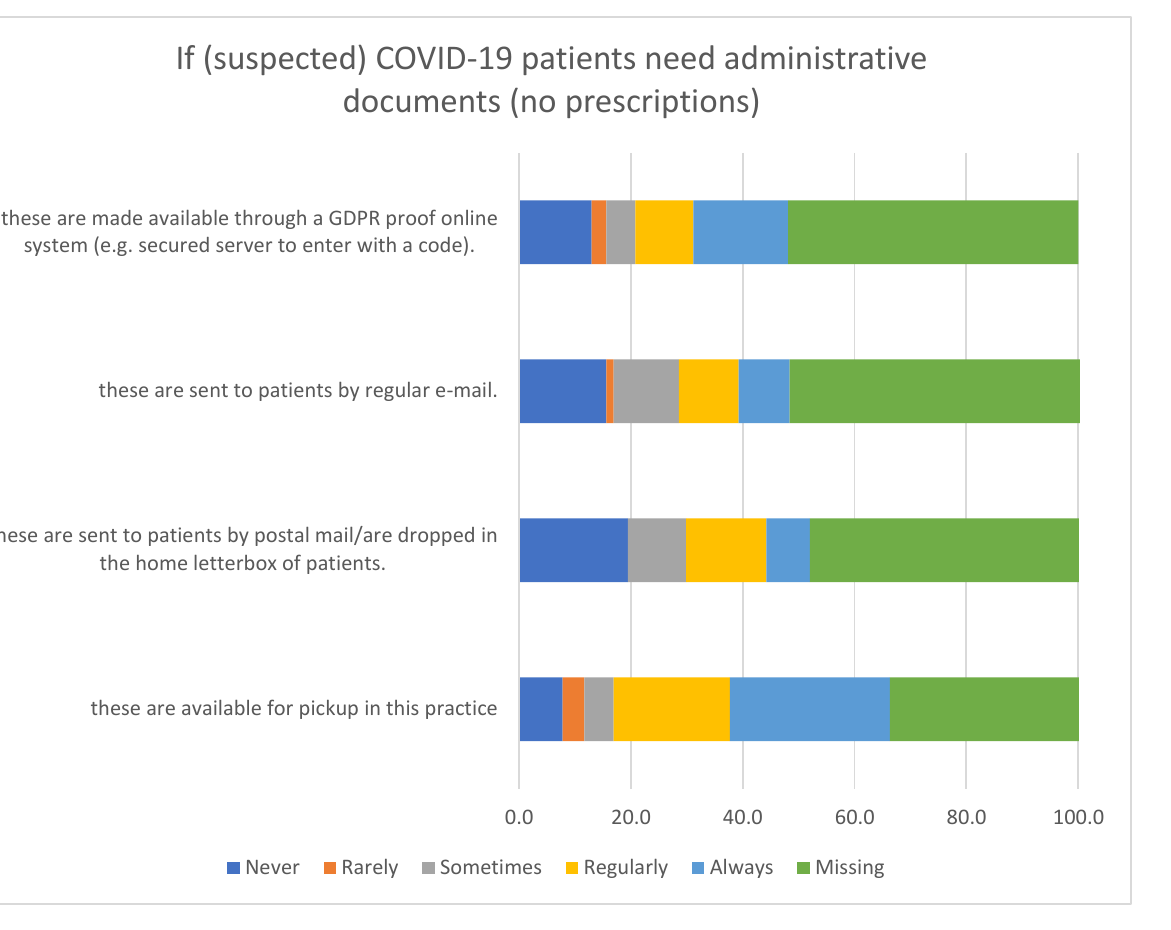
Figure 1. Availability of administrative documents at the Primary Healthcare Practice for suspected COVID-19 patients.